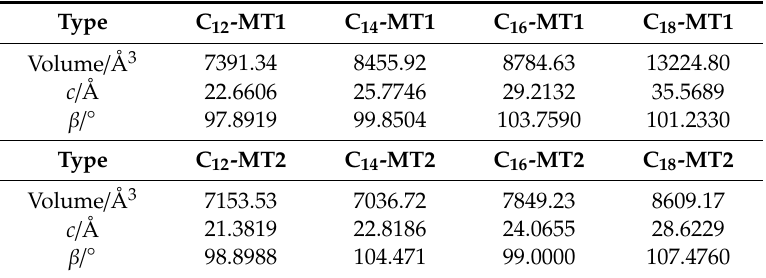
Table 4. The geometry optimization results of organo-MT models.